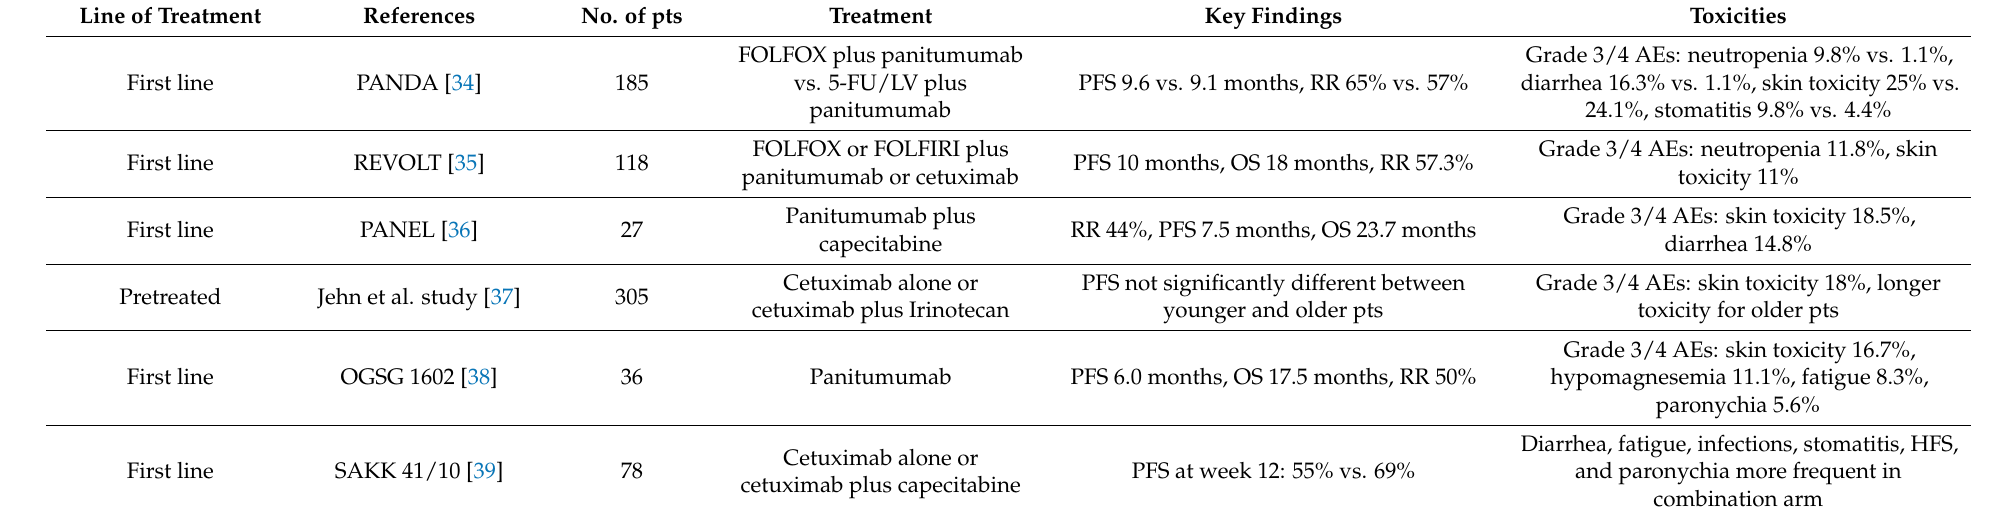
Table 2. Anti-EGFR inhibitors and vulnerable